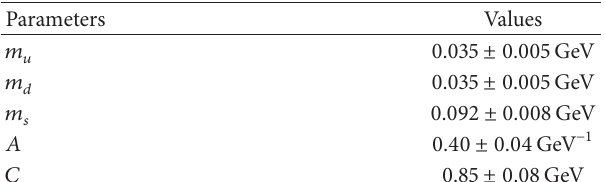
Table 1: The values of the parameters which are taken in our calculations.